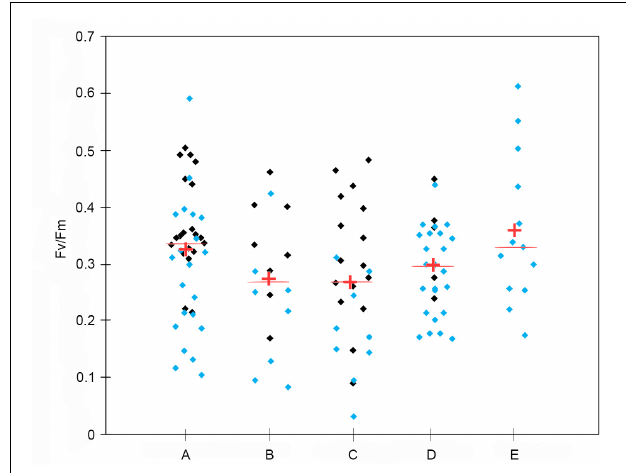
FIGURE 8 | Scattergram of photosynthetic maximum quantum efficiency (Fv/Fm) for different sub-systems: Area 1 (A) , 2 (B) , 3a (C) , 3b (D) , and 4 (E) . Light blue dots indicate samples within UML, and black dots indicate samples below UML. The line is the median and the cross is the